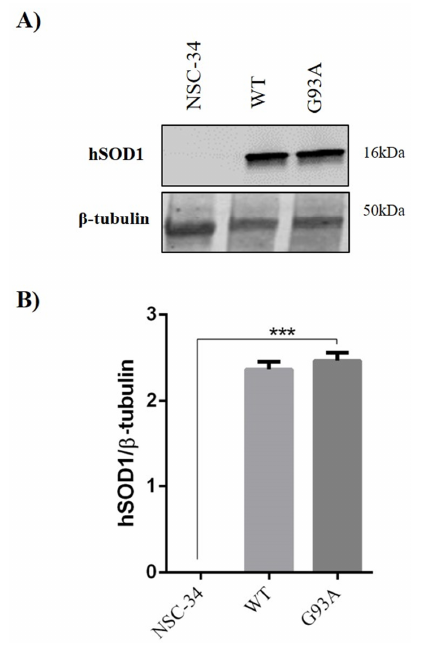
Figure 1. The human Cu/Zn superoxide dismutase1 (hSOD1) expression in neuroblastoma-spinal cord-34 (NSC-34), human wild-type-SOD1 (WT) and G93A cells following doxycycline induction. ( A ) Representative immunoblots of the signals detected for hSOD1 expression in NSC-34, WT and G93A cell homogenates after induction with 2µg/mL doxycycline. ( B ) The bar graph shows the results of three independent experiments. Relative band density was quantified by using the ImageJ software and the protein levels are expressed as the arbitrary units obtained after normalization to β-tubulin, which was used as a loading control. Data are expressed as a mean ± SEM ( *** p < 0.01 vs. NSC-34, as determined by a one-way ANOVA followed by Tukey's post-hoc